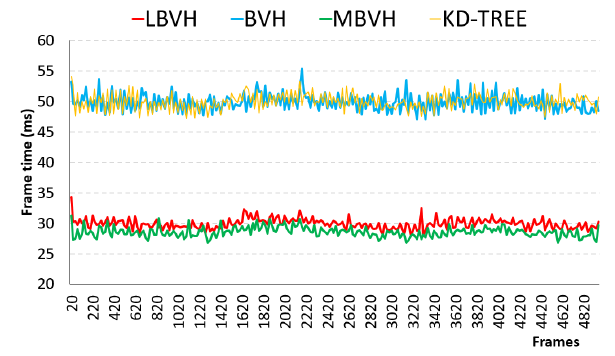
Fig. 8. Comparison of different acceleration data structures for reflections, with a simplified geometric version of the static scene, in the walkthrough animation.